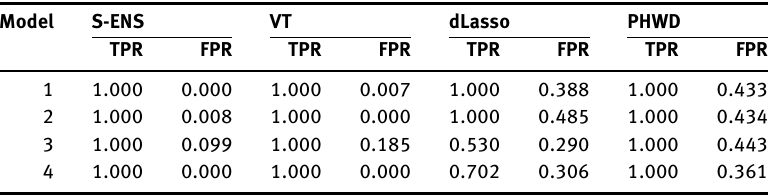
Table 2: Accuracy of variable selection methods. Each cell in the column TPR (FPR) is the average true (false) positive rate of the variable selection method, over 200 simulation samples. “S-ENS” stands for the sparse moment-based estimator, “VT” for the virtual twins method, “dLasso” for the difference lasso approach, and “PHWD” for the method based on Persson etal. [13]. Model S-ENS VT